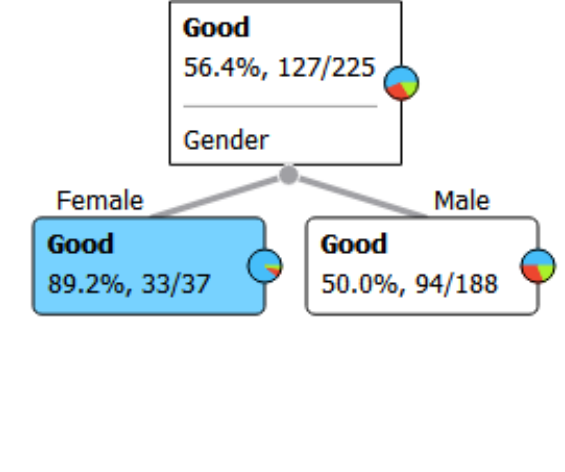
Fig. A5. Classification Tree with gender